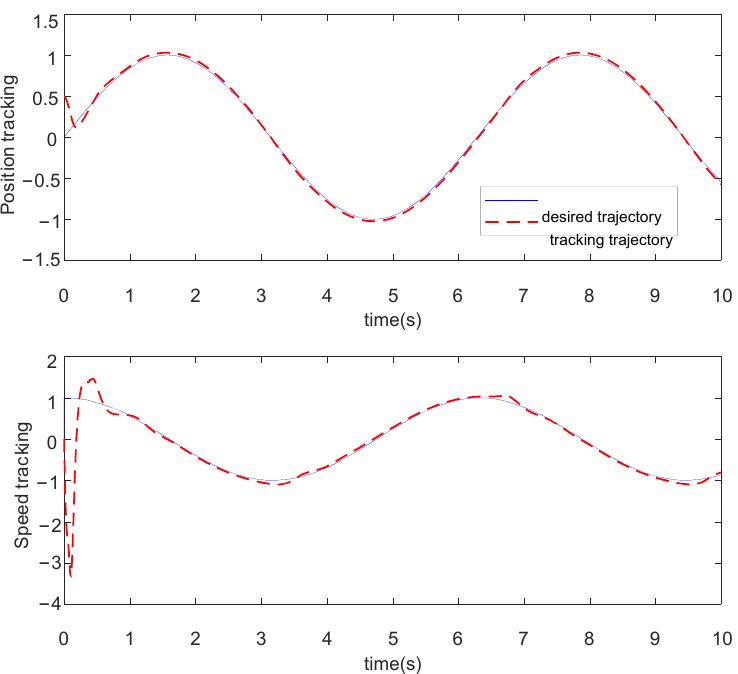
Figure 3. Position and velocity tracking curves without error compensation.